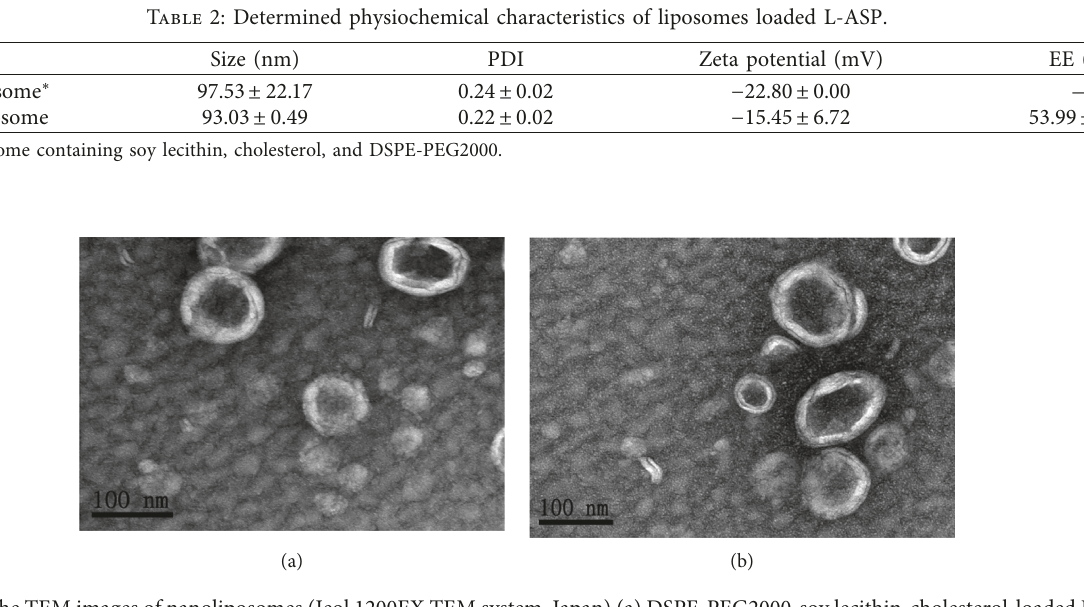
Figure 2: The TEM images of nanoliposomes (Jeol 1200EX TEM system, Japan) (a) DSPE-PEG2000-soy lecithin-cholesterol-loaded L-ASP nanoliposomes; (b) blank liposomal nanospheres.